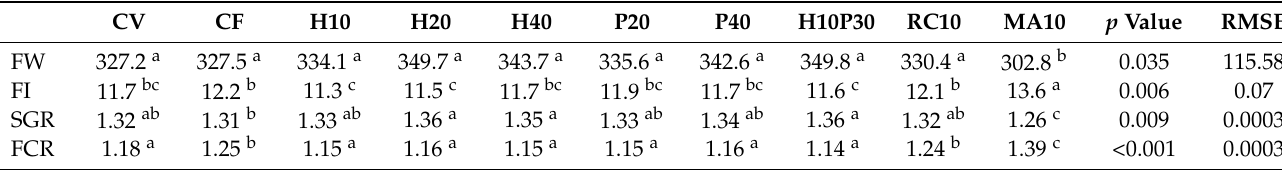
Table 3. Final weight (FW, g), feed intake (FI, g/kg ABW/d), specific growth rate (SGR, g/kg ABW/d) and feed conversion ratio (FCR) of gilthead sea bream ( Sparus aurata ) fed the experimental diets over 21